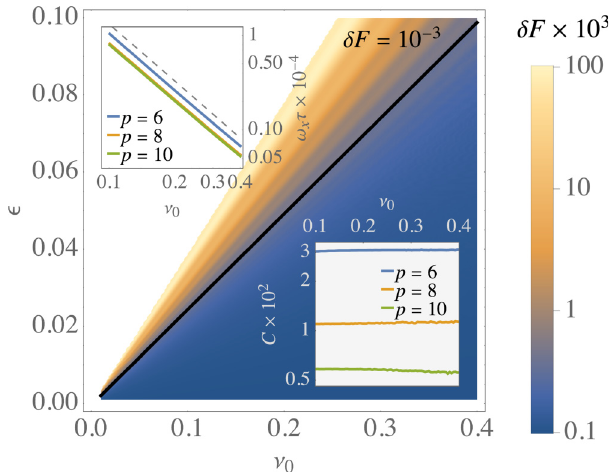
FIG. 5. Gate performance for an infinite chain. The main panel shows the dependence of the infidelity on the parameters ν 0 and (cid:14) . δ F = 10 − 3 on the black line across the diagonal. In the white region, the optical potential is insufficient to decouple the pinned ions from the other ions in the chain. The insets show the gate duration τ and the crosstalk C for fixed infidelity δ F = 10 − 3